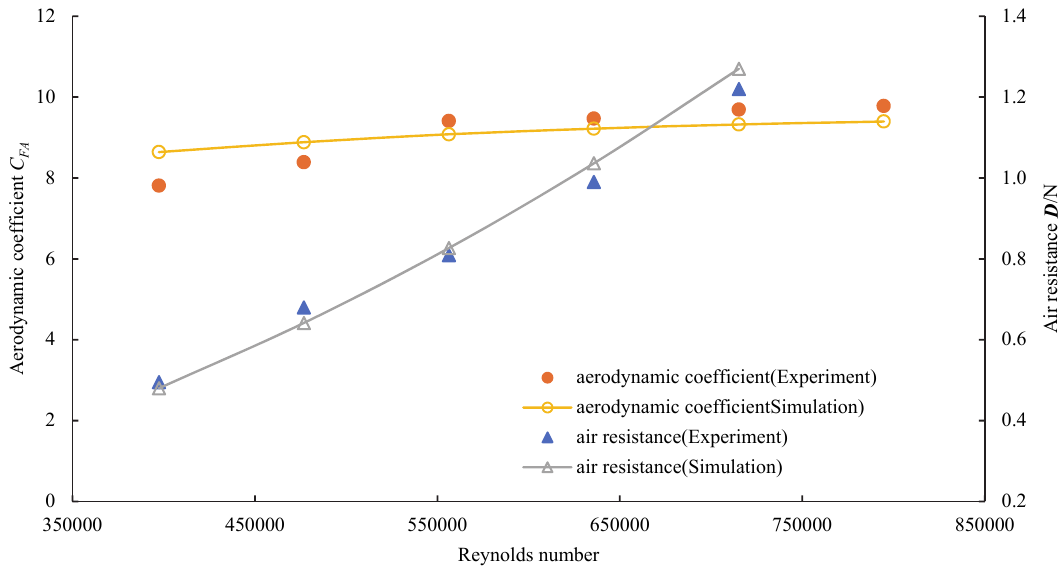
11 of 21 Figure 7. Wind tunnel experiment system. (1) Aircraft support; (2) fan; (3) test UAV sample; (4) six- component strain balance. The wind tunnel test was conducted at the Chinese National Key Laboratory of Science and Technology on Aerodynamic Design and Research. During testing, the pitch angle of the UAV was set at 8°, and the wind speed was stabilized between 12 and 20 m/s using a frequency converter at 2 m/s intervals. The lift–drag ratio and air resistance values of the UAV sample were determined at